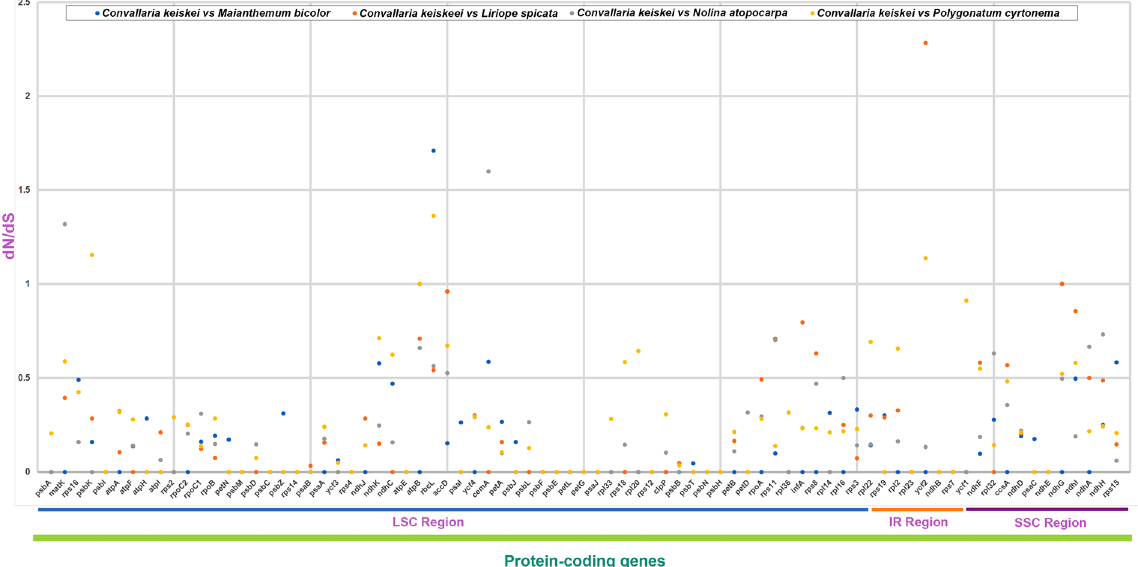
Figure 4. Ratio of non-synonymous (dN) to synonymous (dS) substitutions of 68 protein-coding genes in the Nolinoideae. Blue dots indicate the dN/dS ratio of Convallaria keiskei vs Maianthemum bicolor , orange dots indicate C . keiskei vs Liriope spicata , grey dots indicate C . keiskei vs Nolina atopocarpa , and yellow dots indicate C . keiskei vs Polygonatum cyrtonema